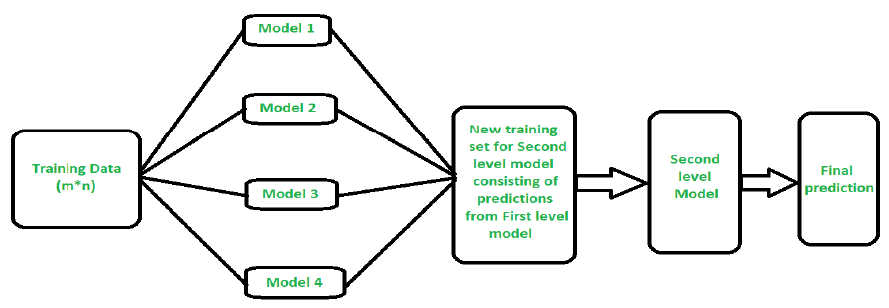
Figure 3. The stacking classifier in detail [25].